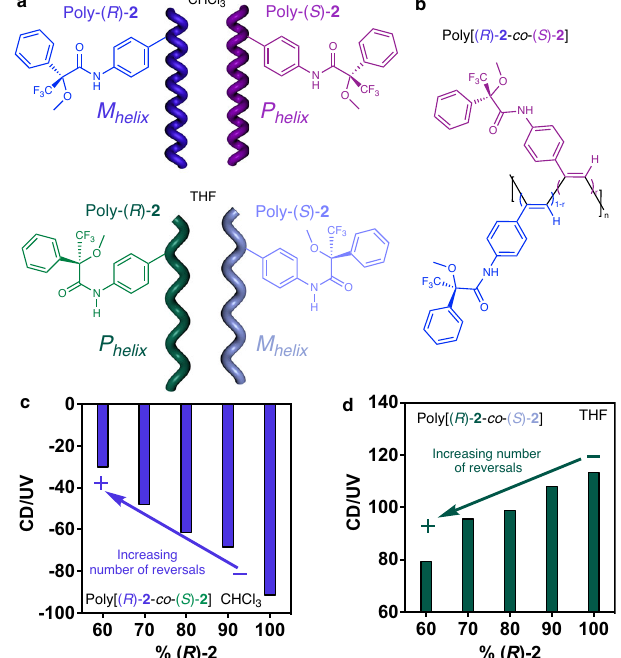
Fig. 5 | Studies with random copolymer series. a Chemical structure and helix sense/elongation representation of poly-( R )- 2 and poly-( S )- 2 in CHCl 3 and THF. b Chemicalstructureofthecopolymerpoly[( R )- 2 -co-( S )- 2 ]. c,d VariationoftheCD/ UV signal vs. percentage of ( R )- 2 in the poly[( R )- 2 -co-( S )- 2 ] series in CHCl 3 (CD@377nm) and THF (CD@378nm), respectively (blue and green bars,